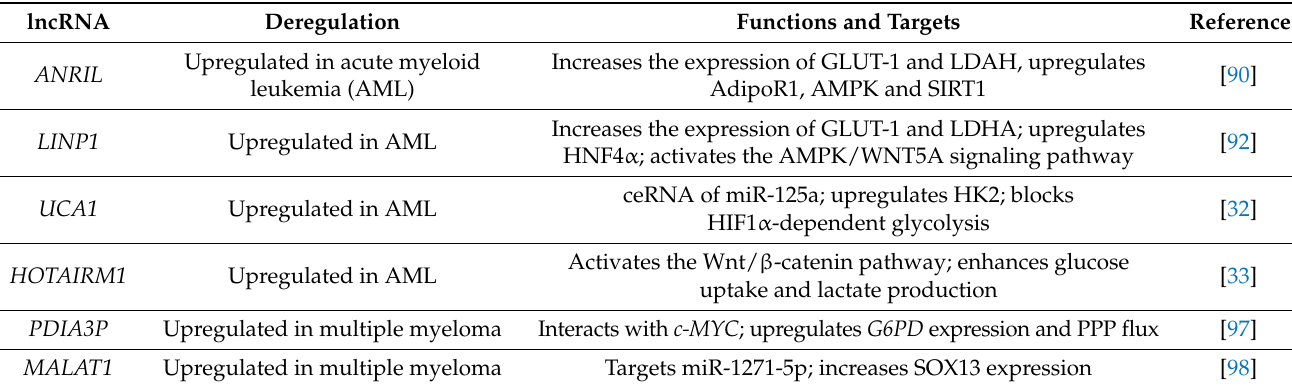
Table 5. Examples of lncRNAs implicated in glucose metabolism alteration in hematologic cancer.